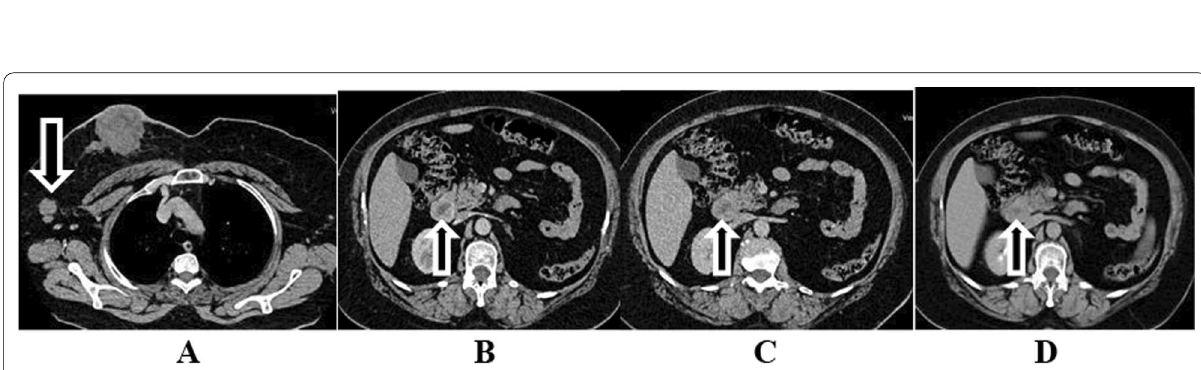
Fig. 4 64‑year‑old female presented with right breast pathologically proved carcinoma. MDCT scan ( A ) revealed right breast mass with right axillary malignant lymphadenopathy (arrow). MDCT scan ( B – D ) revealed periampullary mass (enhanced in arterial phase, washout in portal and delayed phases (arrows) (pathologically proved neuroendocrinal